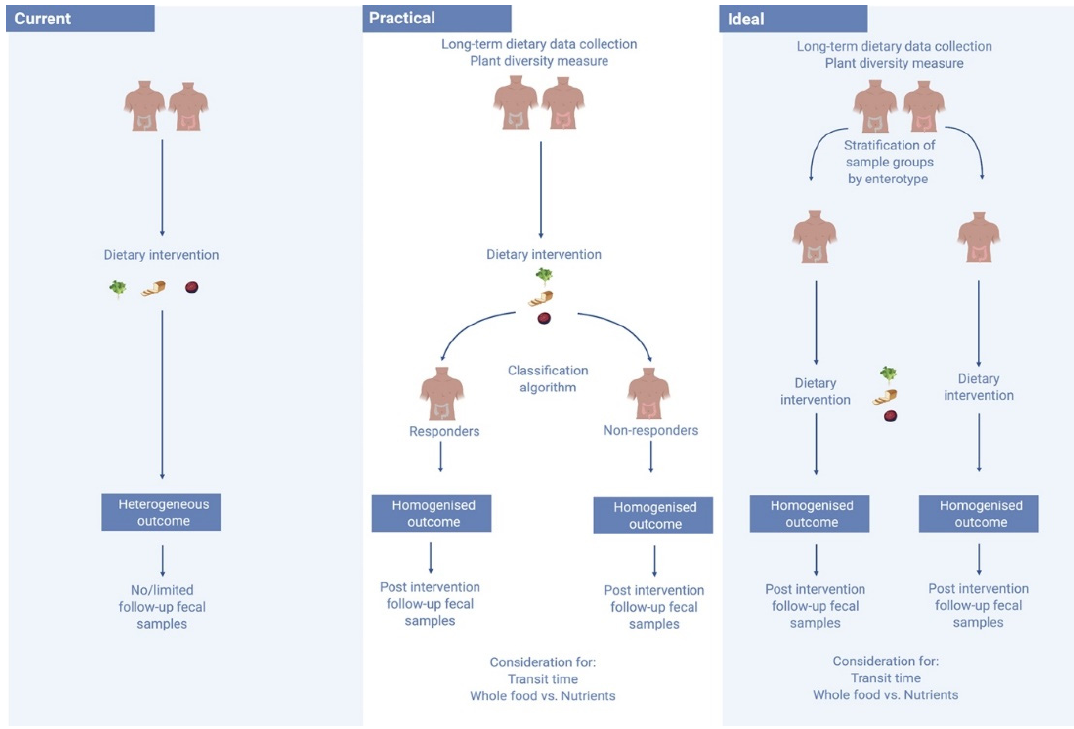
Figure 2. Moving from current to an ideal diet–microbiome study structure. Currently,